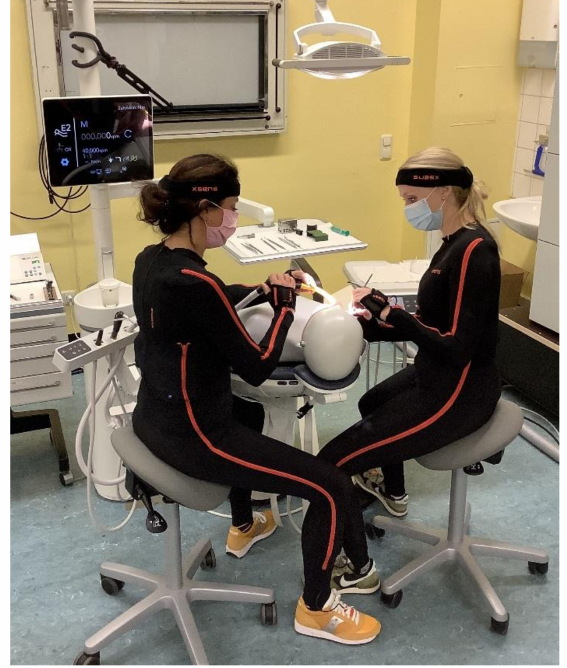
Figure 1. Joint treatment of dentist (right position) and dental assistant (left position) on the dummy head. Both wear the Xsens lycra-suit with seventeen integrated sensors.